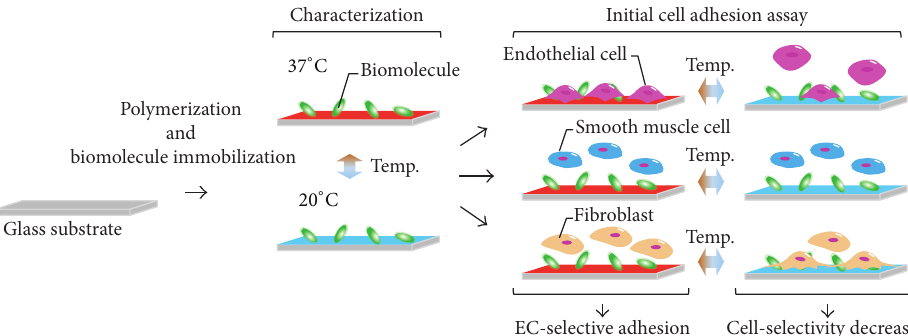
Figure 1: Schematic image of evaluating cell adhesion performance as a combination effect of biomolecules and its immobilized polymer property. Poly(NIPAAm- co -CIPAAm) surface was fabricated to create the cell assay platform. Due to the thermoresponsive polyNIPAAm effect, the cell adhesion performance of the same immobilized biomolecules can be tested; the polymer properties can be compared by changing the temperature. Cell-selective adhesion was compared among three types of cells (ECs, SMCs, and FBs), which control the regeneration process of vascular tissue engineering.